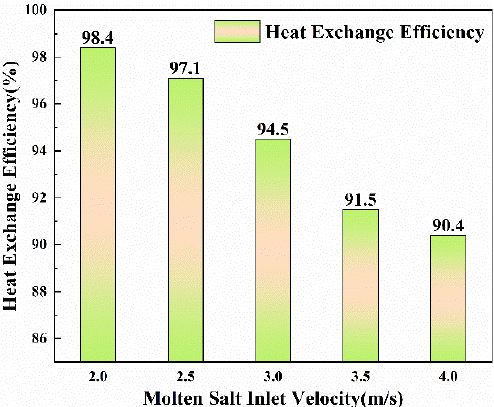
Figure 15. Changes in heat exchange efficiency of molten salt and steam at different flow rates.